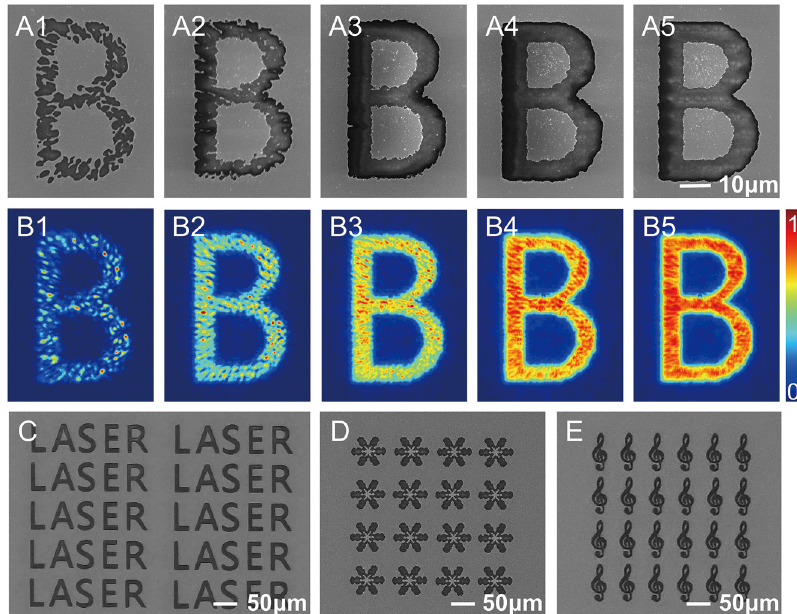
Figure 3: Experimental results of micropattern printing and intensity profile measurement of optical fields. (A1) –